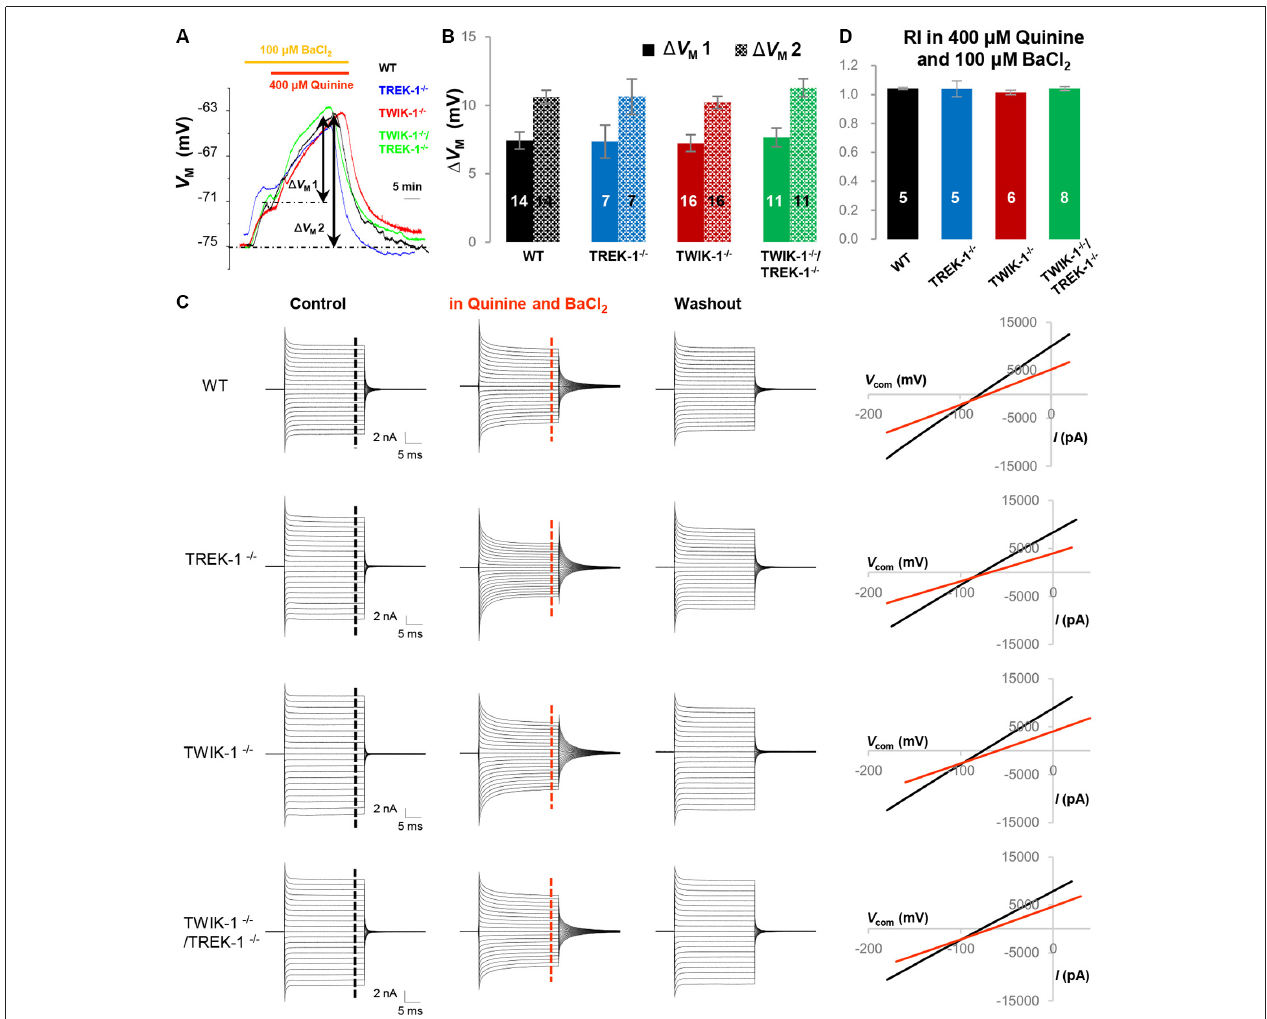
FIGURE 7 | Quinine does not reveal the functional contribution of TWIK-1 and TREK-1 in single or double gene knockout mice. (A) Representative astrocyte V M recordings first in 100 µ M BaCl 2 bath application for 5 min, followed by addition of 400 µ M quinine for 20 min, from a WT, TREK-1 − / − , TWIK-1 − / − and TWIK-1 − / − /TREK-1 − / − astrocyte as indicated in situ . (B) Summary of 400 µ M quinine-induced V M depolarization ( ∆ V M 1) and the total V M depolarization induced by BaCl 2 plus quinine from all four genotypes. (C) Representative whole-cell current recordings first in aCSF as control, then in 100 µ M BaCl 2 plus 400 µ M quinine, and washout. Representative I–V relationships were shown in the right panel. (D) Summary of RI values from four genotypes obtained from astrocyte recordings in the presence of 400 µ M quinine and 100 µ M BaCl 2 together in bath. The RI values were comparable among the four